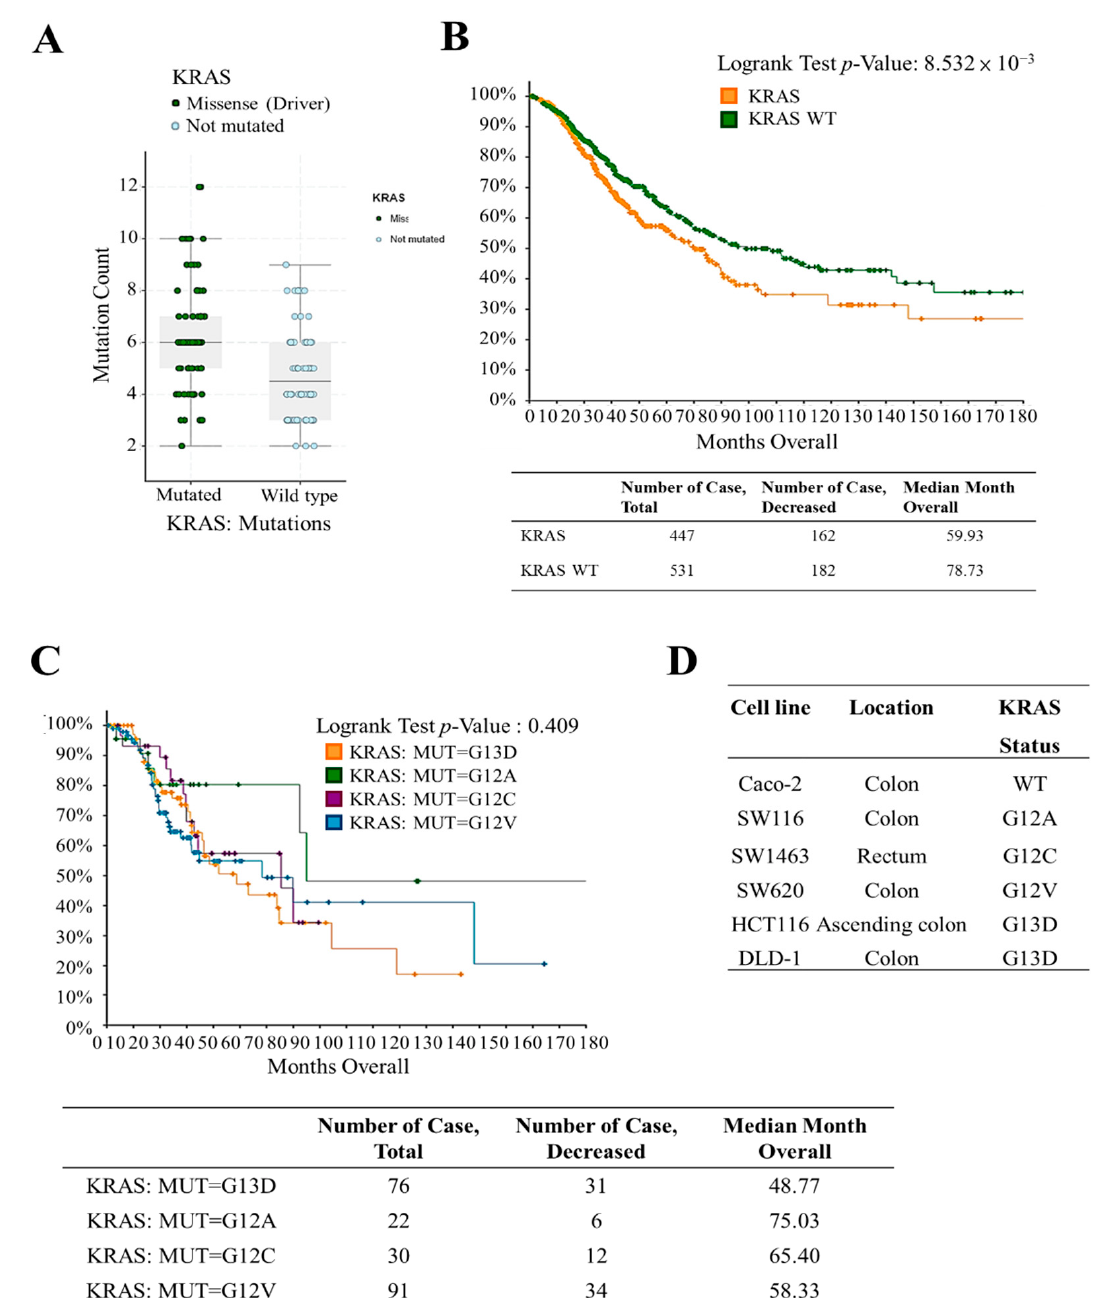
Figure 1. Prevalence of KRAS mutation in patients with colorectal cancer (CRC). ( A ) KRAS mutation count of The Cancer Genome Atlas (TCGA) metastatic colorectal cancer (MSKCC) cohort (MSKCC 2018, n = 1134). ( B ) Kaplan–Meier plot showing the overall survival of MSKCC patients according to the genetic profile (KRAS mutation vs. KRAS wild type). ( C ) Overall survival in different subgroups of KRAS mutation (G12A, G12C, G12V, and G13D) obtained by using the same MSKCC colorectal cancer cohort. ( D ) Tissue origin and KRAS status of CRC line recruited in this study. The source of the cell’s information was acquired from SIB Bioinformatics Resource